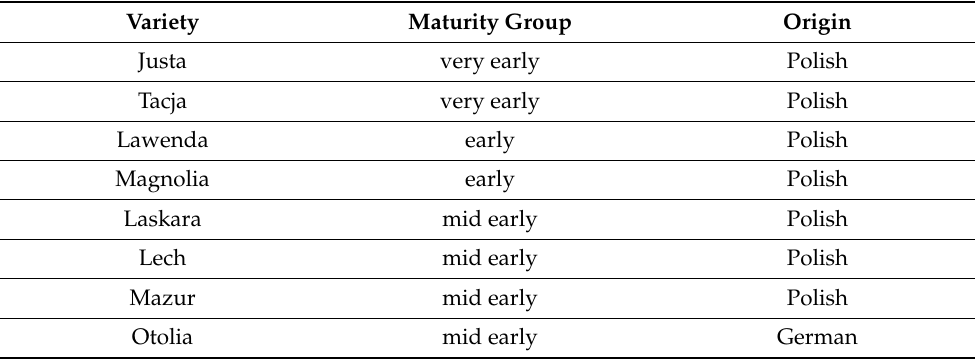
Table 2. Characteristics of potato varieties evaluated in organic and conventional production systems during